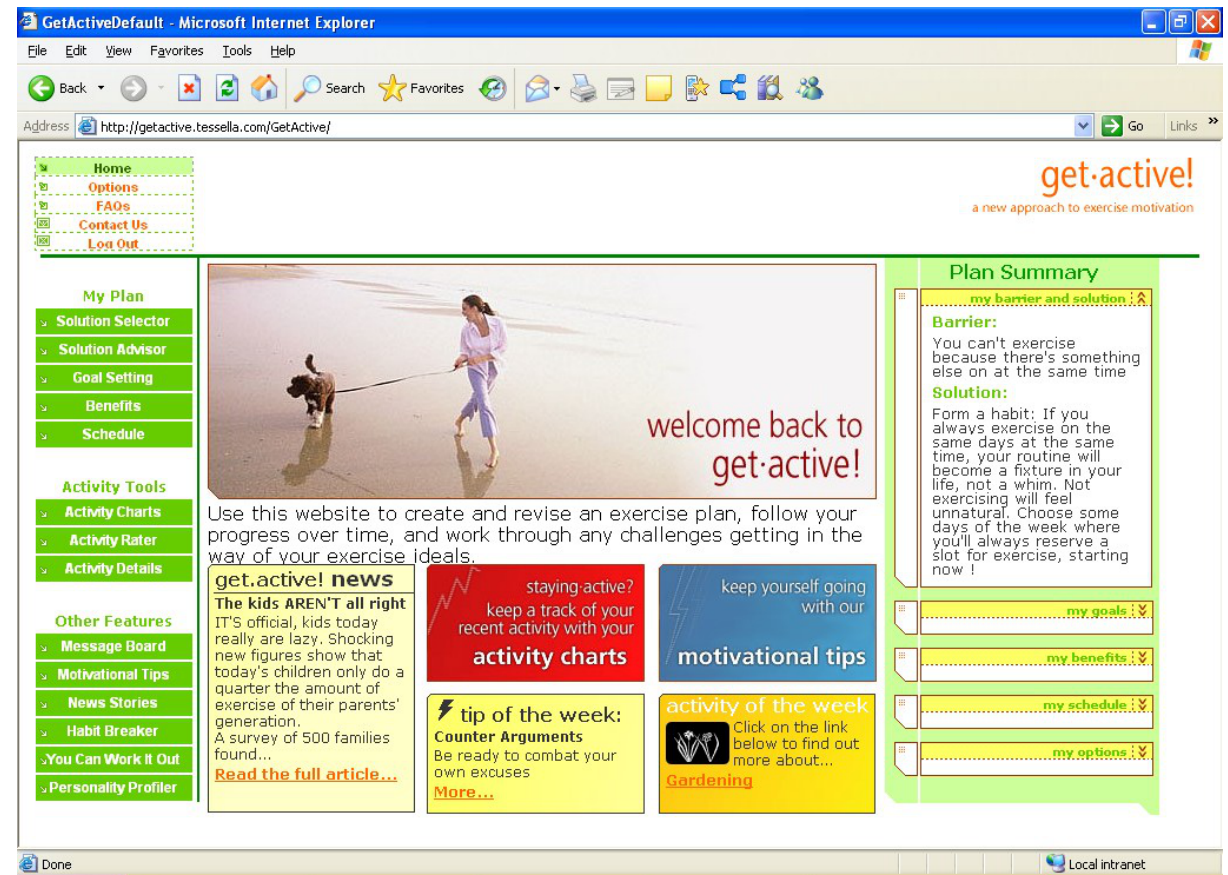
Figure 2. Behaviour change system home